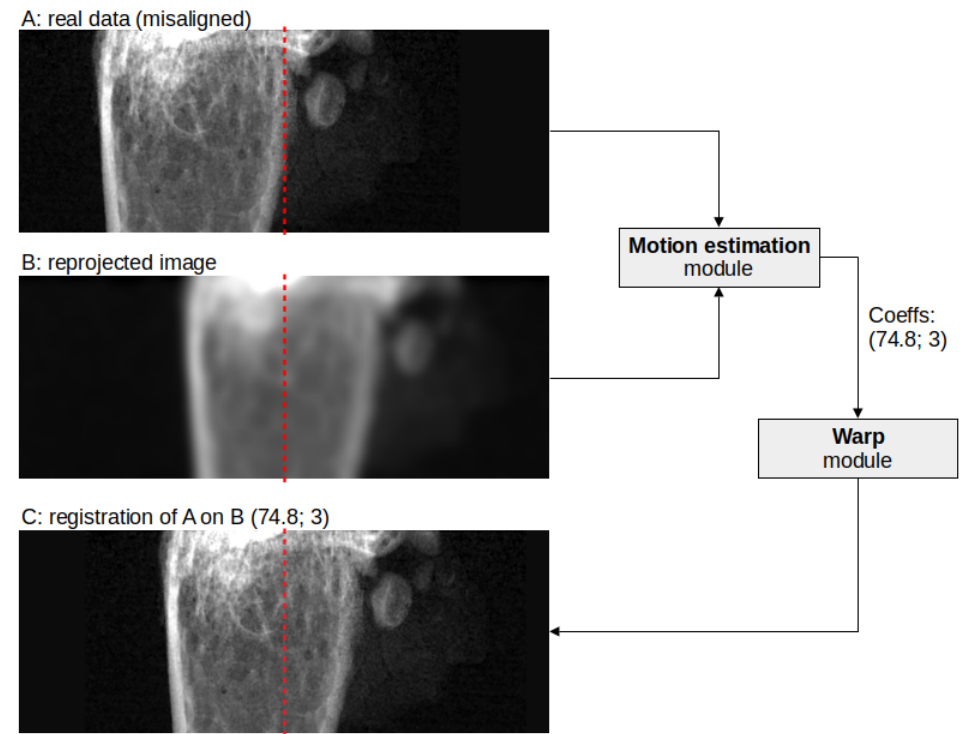
Figure 1. Illustration of the reprojection algorithm concept: a real projection ( A ) is affected by a severe misalignment in the x axis. A tomography reconstruction (not shown) will exhibit blurred details due to this defect. The synthesised projection ( B ) calculated for the same projection angle of ( A ) will be severely blurred but centred. A similarity measure is used to infer the parameters of the geometry transform which realigns ( A ) on ( B ), iteratively producing an aligned